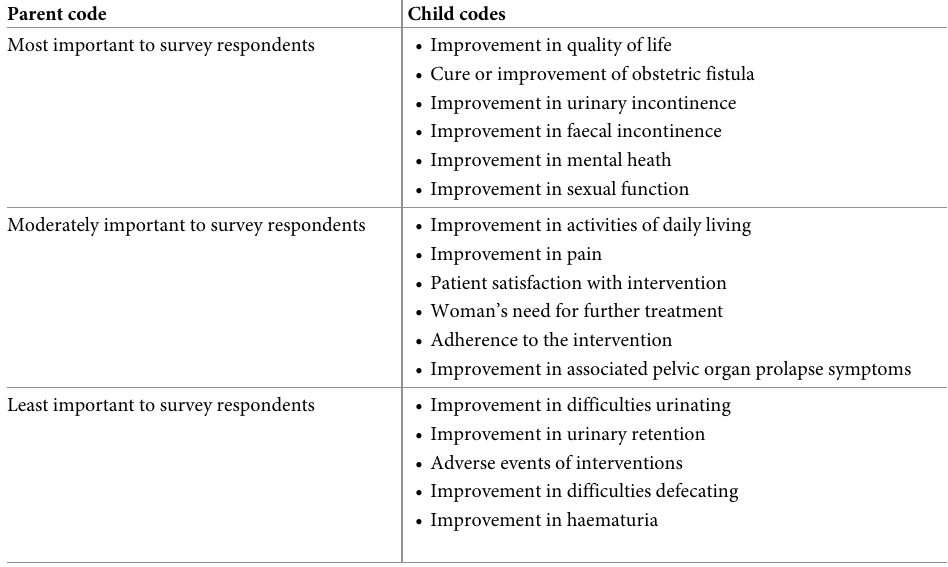
Table 3. Structure of outcomes for evidence map columns based on survey